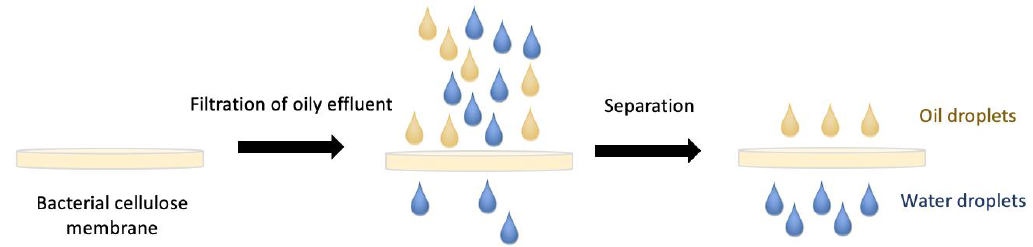
Figure 6. Schematic representation of oil–water separation process using BC as a filter.